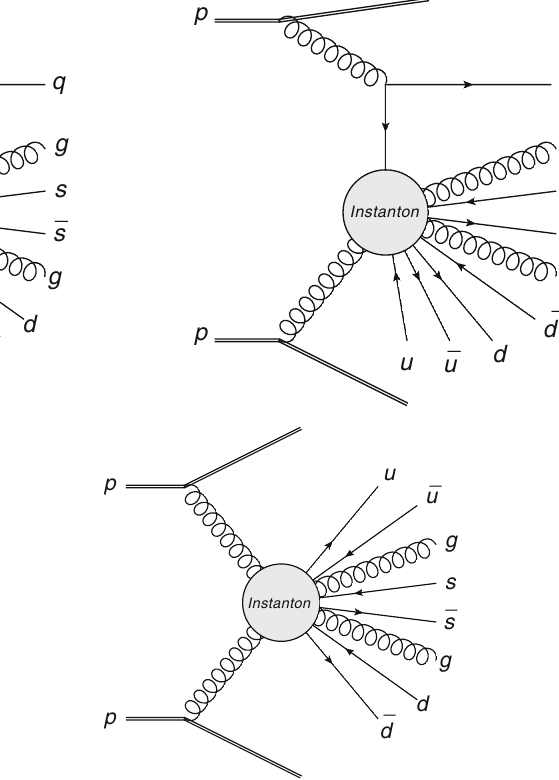
Fig. 2 Depiction of a QCD Instanton processes in electron–proton (left) and proton–proton (right) collisions, where an external scale parameter Q (cid:4) is required